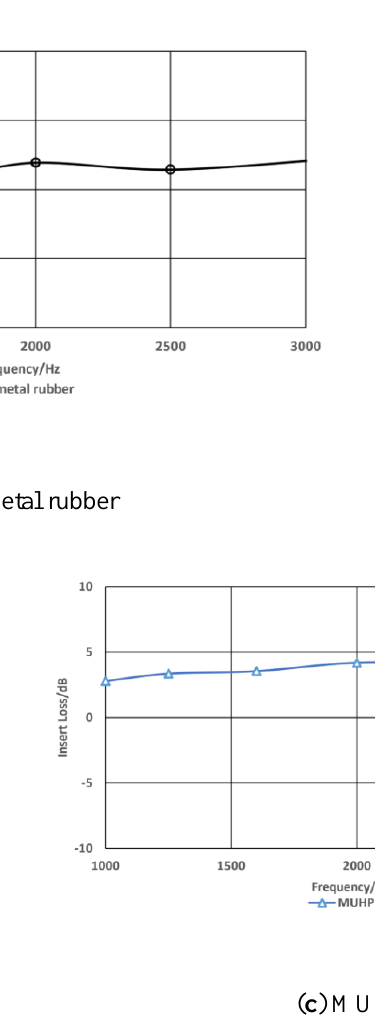
Figure 9. Insertion losses of the three new isolators.